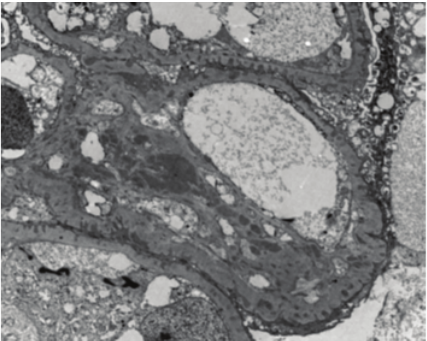
Figure 2: Electron microscopy showing extensive foot process effacement, numerous subepithelial deposits with GBM reaction- spike formation, and occasional enveloping of deposits. There are occasional mesangial deposits. Fibrin deposition was noted within Bowman’s